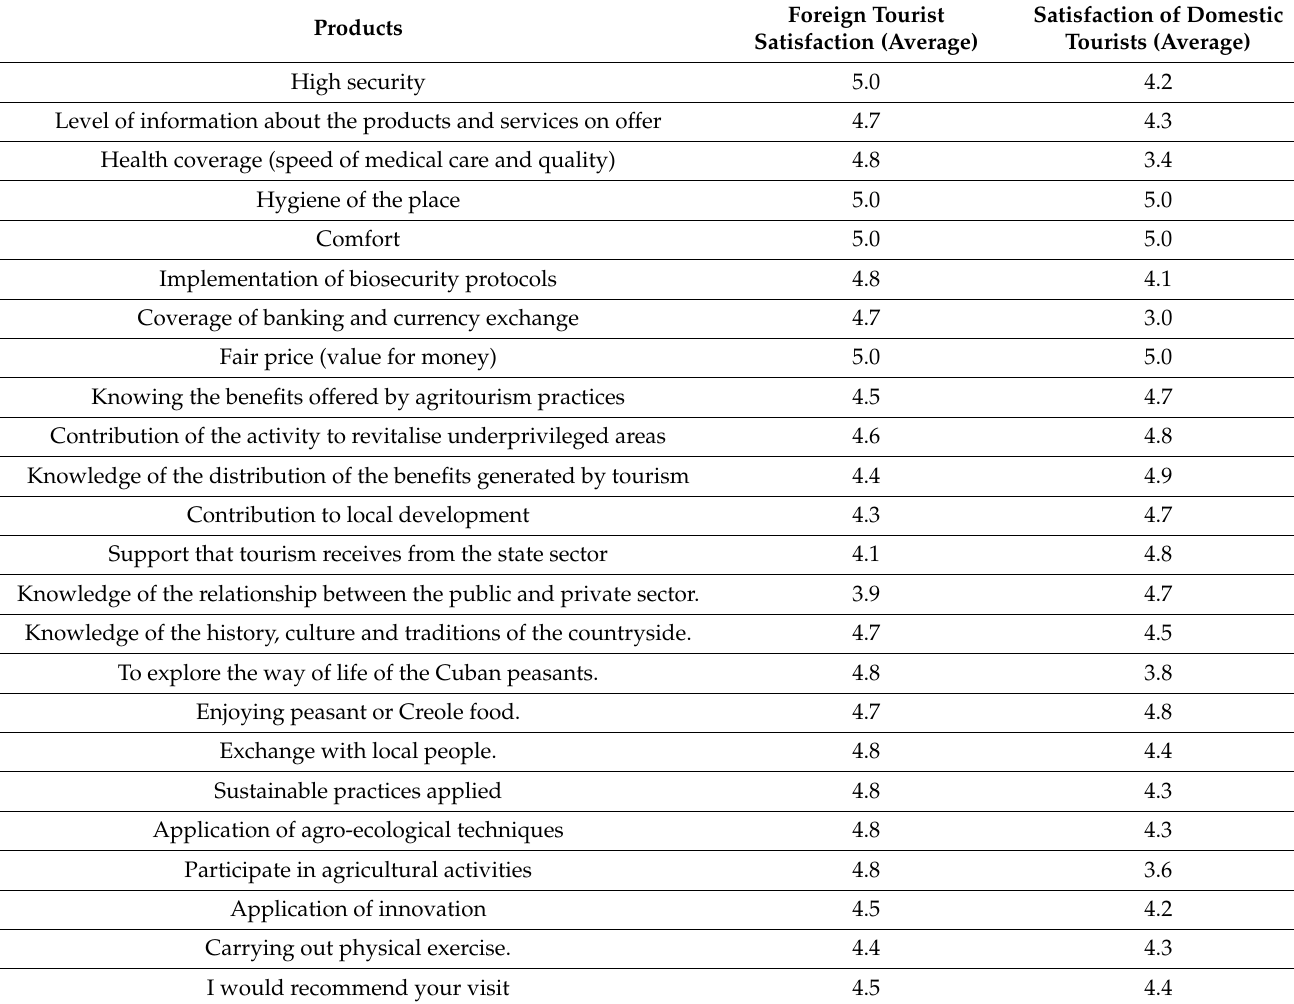
Table 3. Preference of tourists for the products offered.